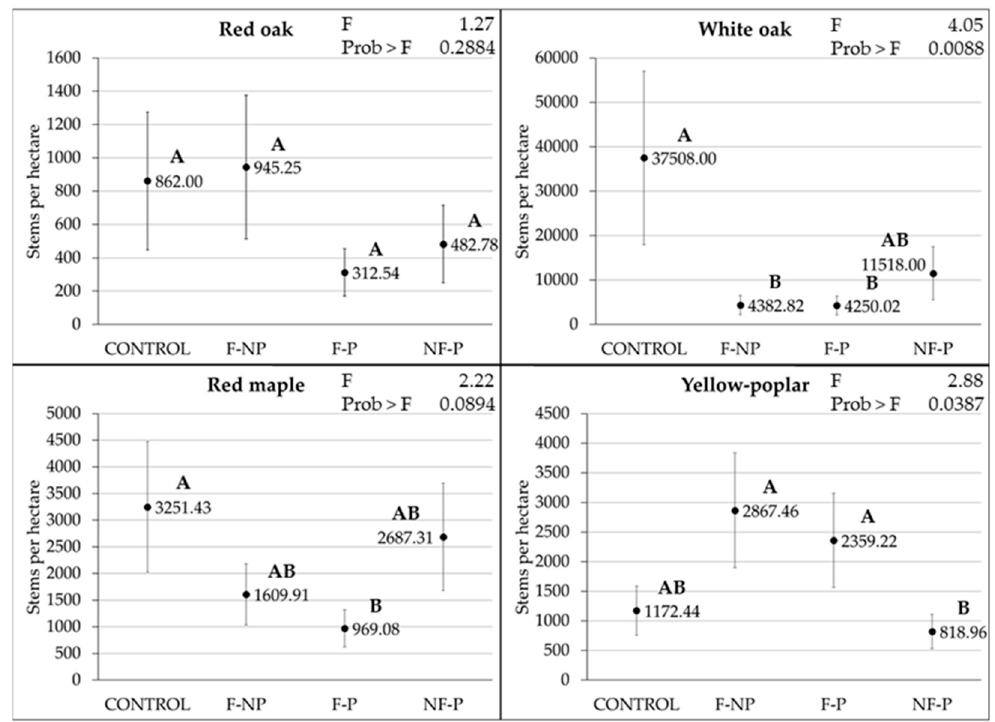
Figure 1. Plots of the least square means with standard errors showing the effects of wildfire and the invasive paulownia ( Paulownia tomentosa ) species on the number of regenerating stems (<137 cm height) per hectare for red and white oaks ( Quercus sp.), red maple ( Acer rubrum ), and yellow-poplar ( Liriodendron tulipifera ). Mean values are displayed and means with the same capital letters (A, B, C, D) are not significantly ( p = 0.05) different between treatments within each species. The treatments include fire with no paulownia present (F-NP), fire with paulownia present (F-P), and no fire and paulownia present (NF-P). The treatment no fire and no paulownia present (NF-NP) serves as the control.